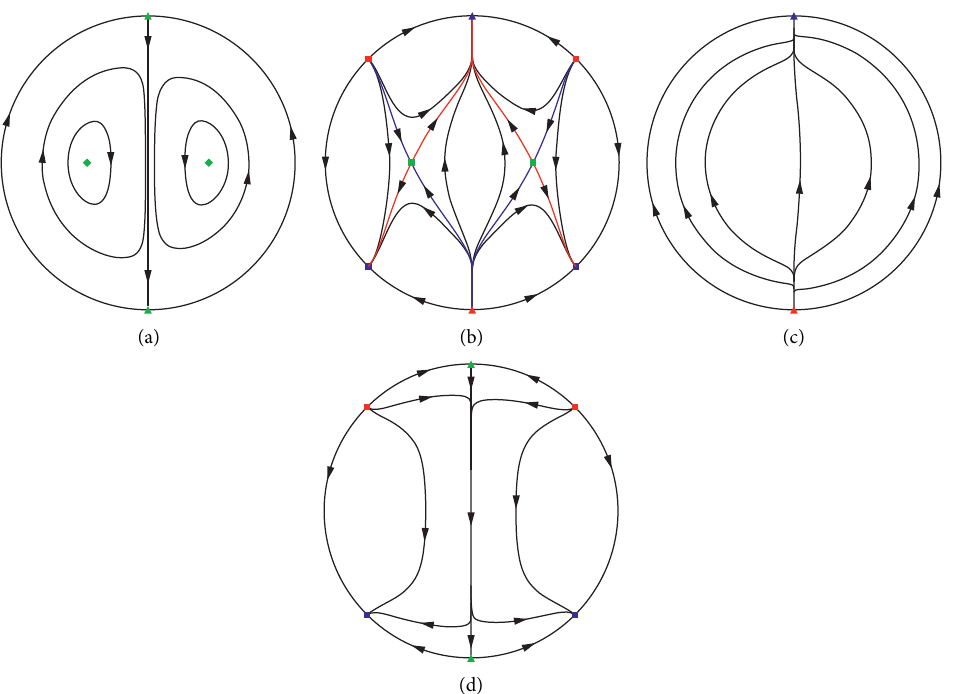
Figure 10: Trajectories in the global phase portraits of system (12). (a) Trajectories in the global phase portraits of system (12) for b > 0 and c > 0. (b) Trajectories in the global phase portraits of system (12) for b < 0 and c < 0. (c) Trajectories in the global phase portraits of system (12) for b < 0 and c > 0. (d) Trajectories in the global phase portraits of system (12) for b > 0 and c <